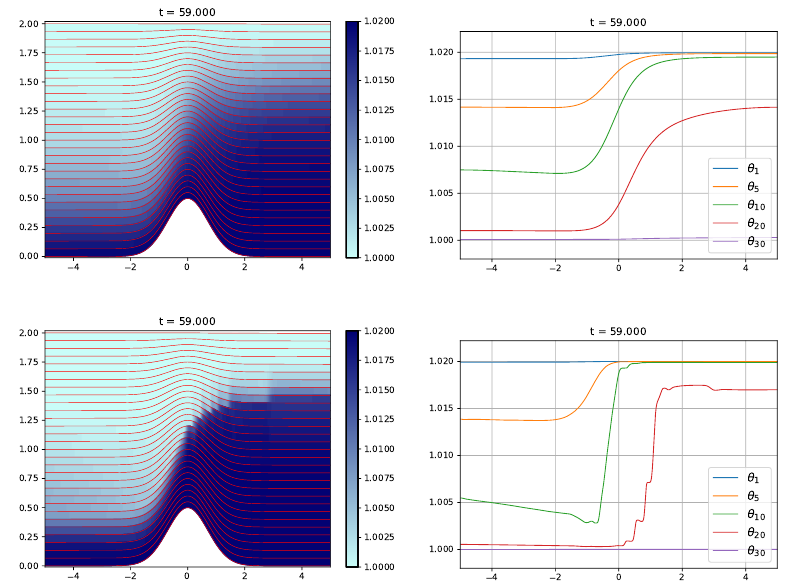
Figure 33. Distribution of the relative density θ . The first row corresponds to the first order scheme and the second row to the second order